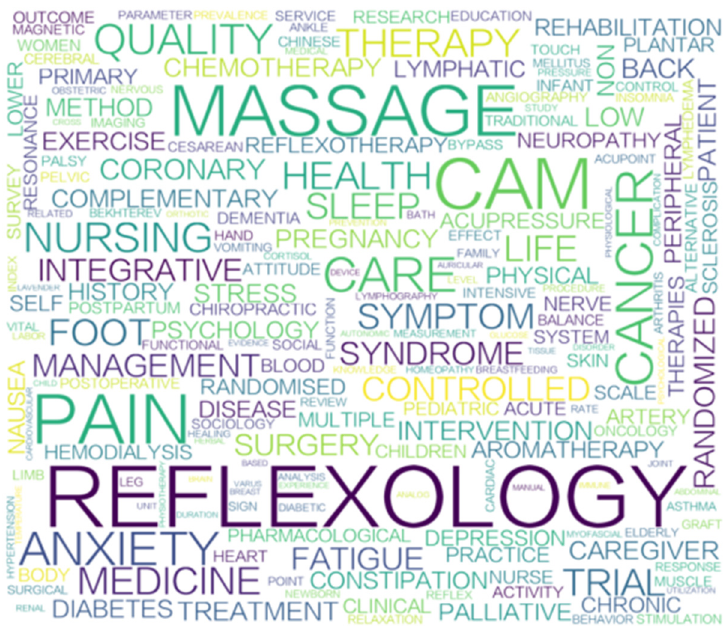
Figure 7. Reflexology keyword cloud.